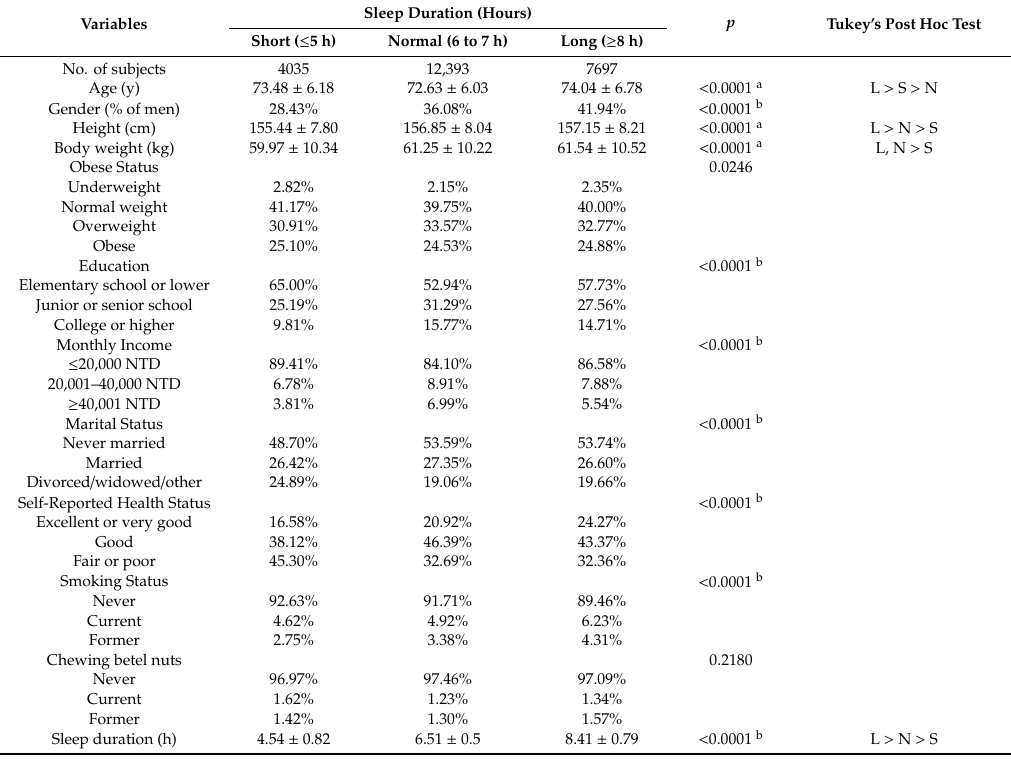
Table 1. Demographic characteristics of study subjects according to sleep-duration levels. Variables